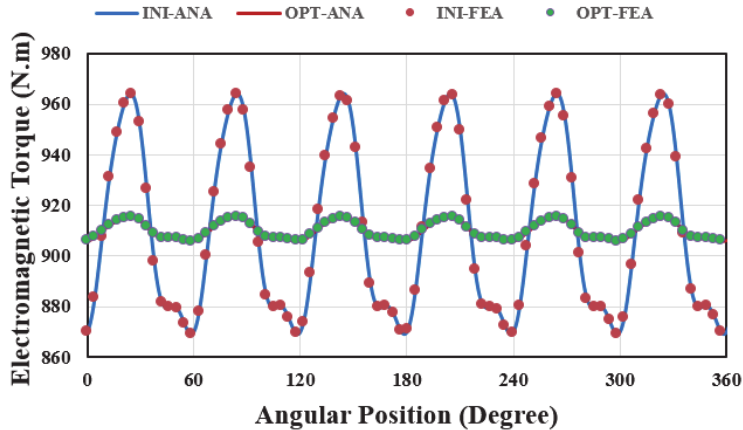
Figure 10. An on-load analytical and numerical comparison of the electromagnetic torque for the 12S-10P motor.